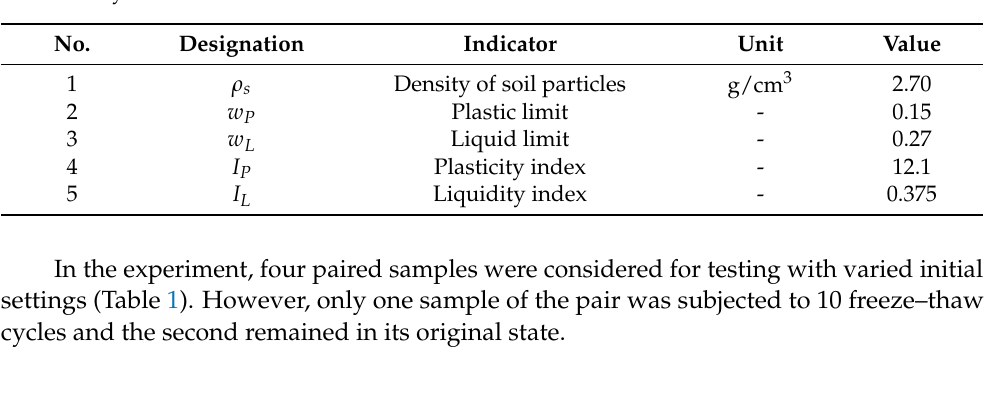
Table 1. Physical characteristics of the